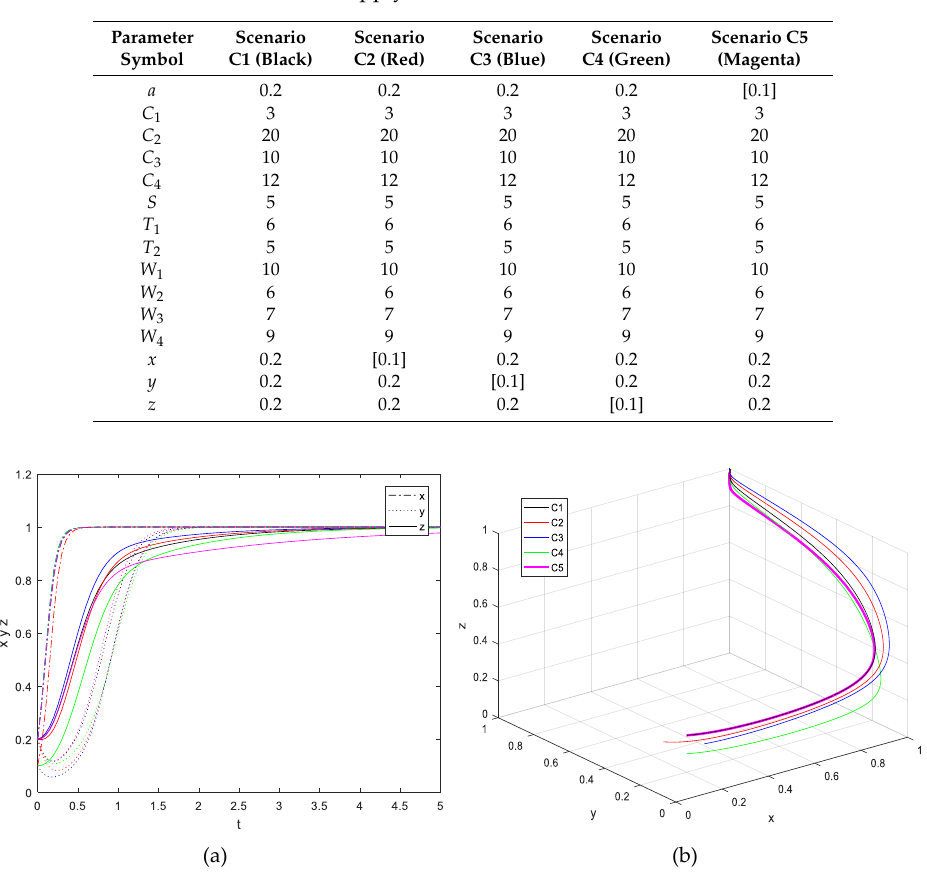
Figure 6. System evolution trend chart of supply and demand coordination scenario. ( a ) Two- dimensional evolution diagram, ( b ) Three-dimensional evolution diagram.